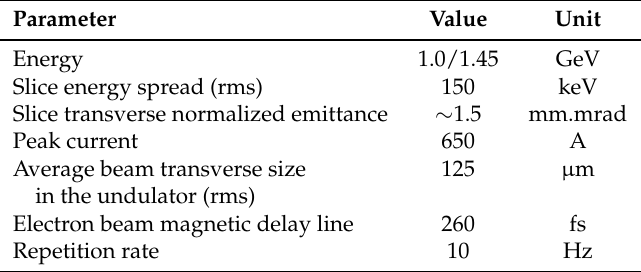
Figure 1. FERMI FELs layout: FEL-1 single-stage HGHG configuration ( top ) and FEL-2 double-stage cascaded HGHG configuration ( bottom ). Table 1. Electron beam parameters used in the experiment.